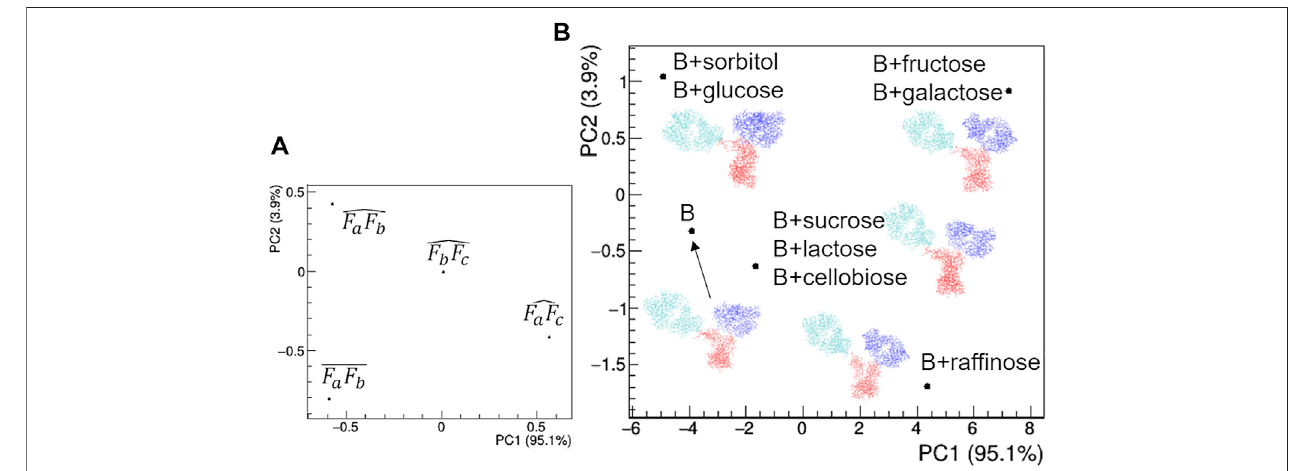
FIGURE15 | Comparison of thestructuralmodels based on PCA of geometrical featuresofrituximab models obtained from SAXS measurementsin the presence of several additives. (A) PCA loadings values showing the role of individual geometrical parameters in discriminating the models; (B) PCA scores values showing the model discrimination. The models are drawn next to their representative points, with Fa, Fb and Fc coloured in cyan, blue and red, respectively. The fraction of the total data variance explained by the fi rst (PC1) and second (PC2) principal component is reported on relative the axes of the loadings (A) and scores (B) plots.